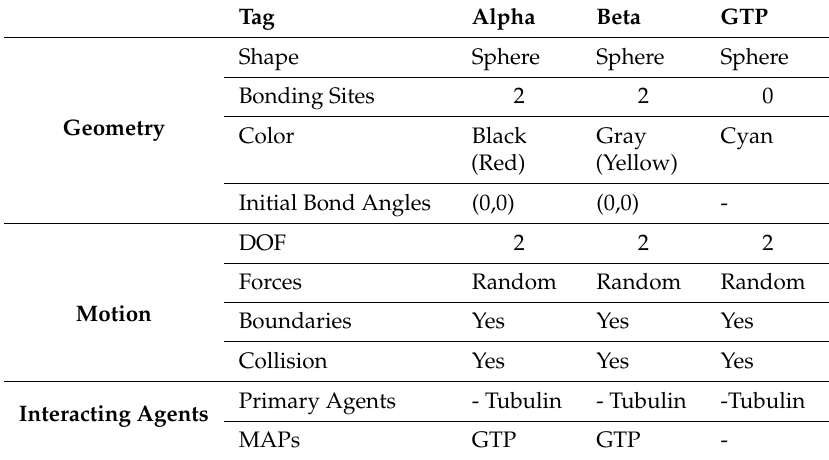
Table 1. Summary of Agent